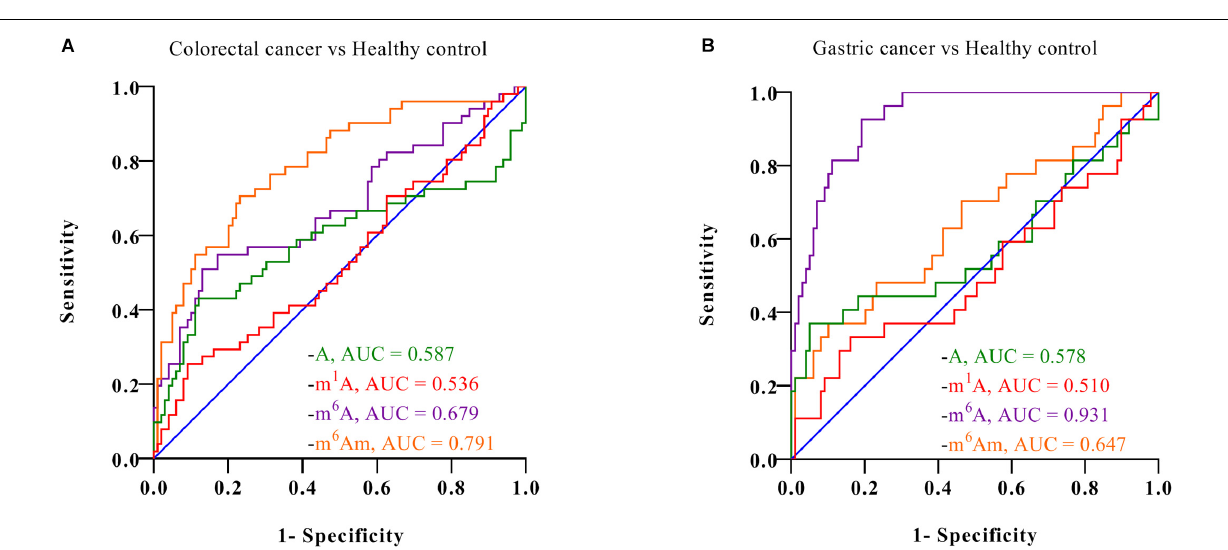
FIGURE 4 | The measured concentrations of (A) A, (B) m 6 A, (C) m 1 A, and (D) m 6 Am in serum samples and statistical analysis.